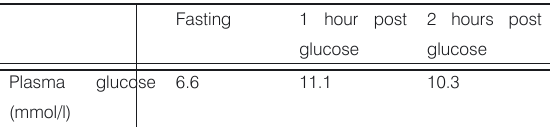
Table 3. OGTT at 10 weeks.